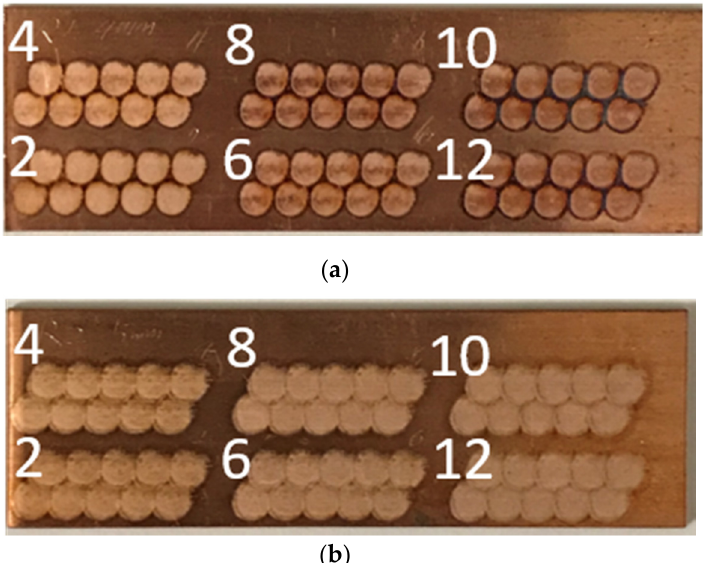
Figure 2. Photographs of the laser-processed area on copper using the spot-by-spot method with laser spot sizes of: ( a ) 4 mm and ( b ) 5 mm. The photos were taken immediately after processing. The label numbers correspond to conditions shown in Table A1.